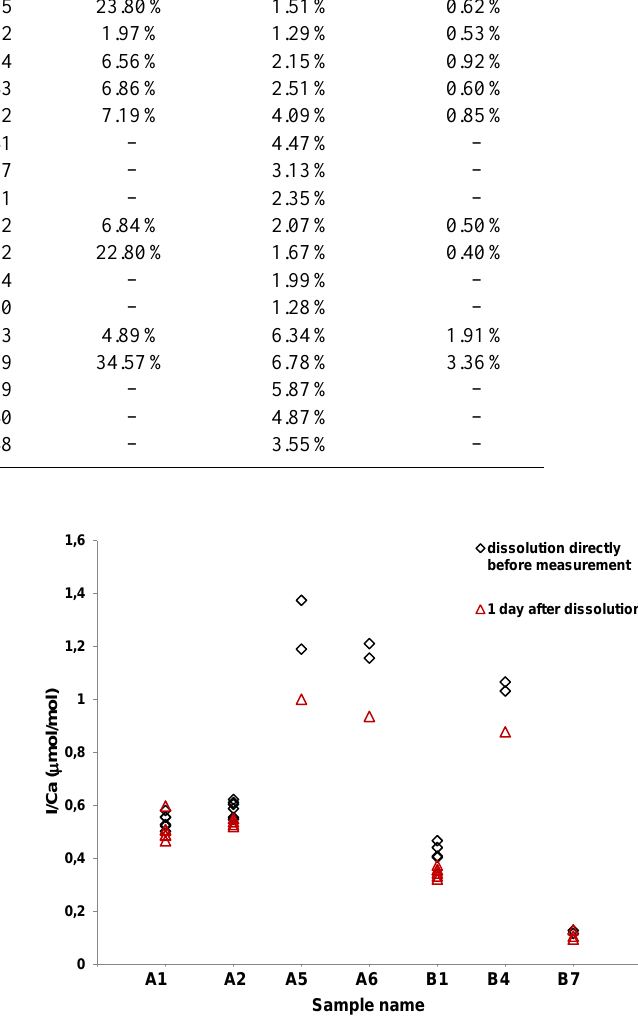
Table 5. Mean I / Ca ratios, number of measurements ( n ) and errors for the reference standards and foraminiferal samples at the different sampling sites. The variability represents the standard deviation between all measurements of the sample/standard. Standard/ Sampling n I / Ca Variability Mean precision 1 σ of mean species site for single precision measurement (1 SD) Calcite 70